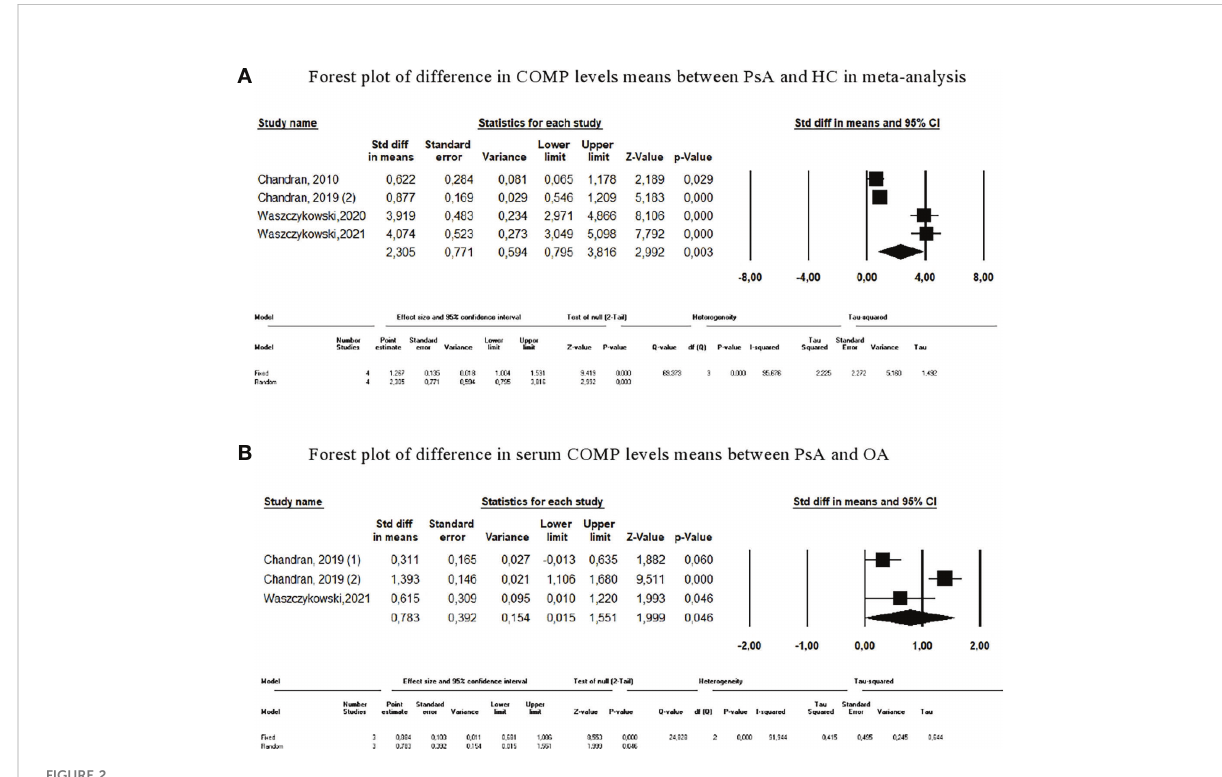
FIGURE 2 Meta-analysis of COMP levels. (A) Forest plot of difference in COMP levels means between PsA and HC in meta-analysis. (B) Forest plot of difference in serum COMP levels means between PsA and